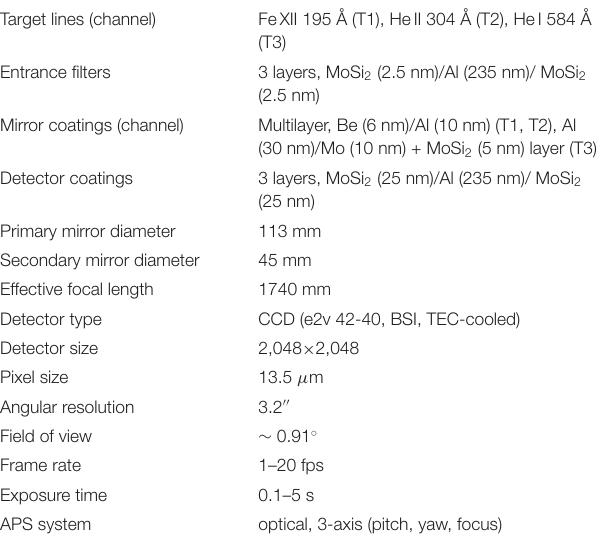
TABLE 2 | Main characteristics of telescopes. Target lines